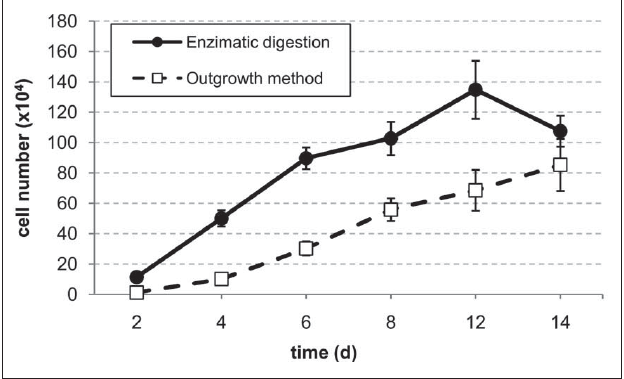
Fig. 3. Primary dental pulp cells growth curves comparing different methods, outgrowth and enzymatic digestion using colagenase type I plus dispase, cultured with D-MEM supplemented with 20% FBS.